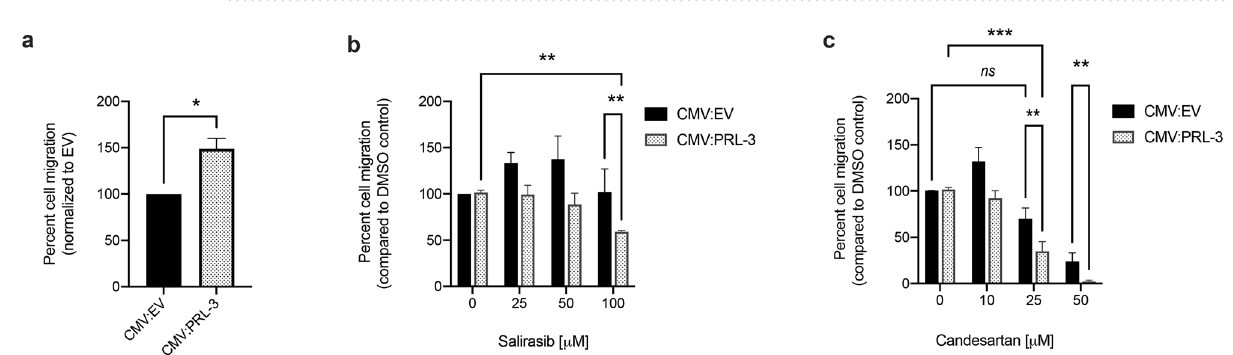
Figure 4. Salirasib and Candesartan inhibit PRL-3 induced cell migration in HEK293T cells. ( a ) Quantification of cell migration of HEK293T cells transfected with a either PRL-3 expression vector or empty vector control. Cells from (a) were treated with either ( b ) Salirasib or ( c ) Candesartan at the doses indicated. The zero drug dose was a 1% DMSO control, and each data set was compared to the DMSO control group within that data set. Both drugs inhibited cell migration to a greater extent in the PRL-3 overexpressing cells, compared to empty vector (EV) control. * p = 0.089 using one tailed student t test with Holm Sidak correction, ** p = 0.03, *** p = 0.001, ns = no significant difference, using a two-way ANOVA with Dunnett’s